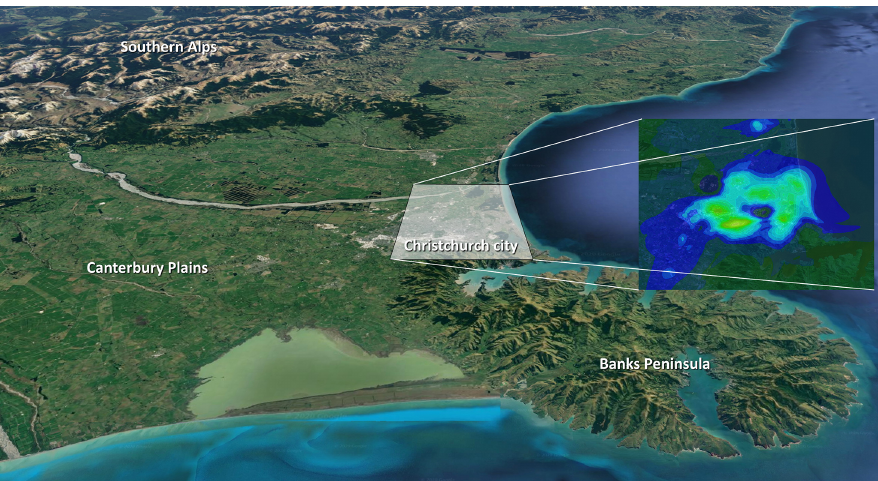
Figure 1. The geographical context for Christchurch showing the Southern Alps to the west, Banks Peninsula to the east, and the Canterbury Plains between the city and the Southern Alps. The inset shows a typical PM 2 . 5 distribution around the city. Background image: © Google, Maxar